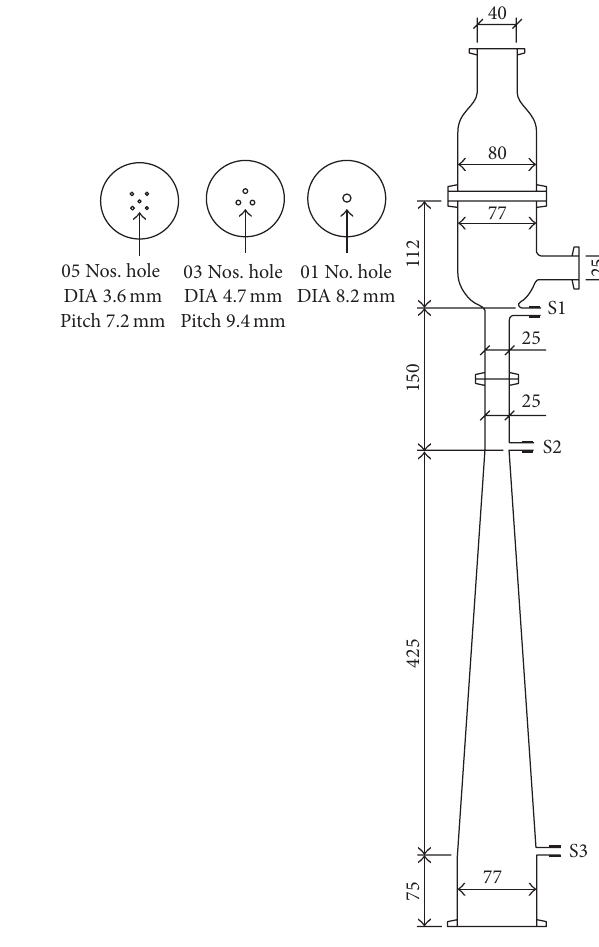
Figure 3: Detail of the ejector used in the experimental setup [31, 111,